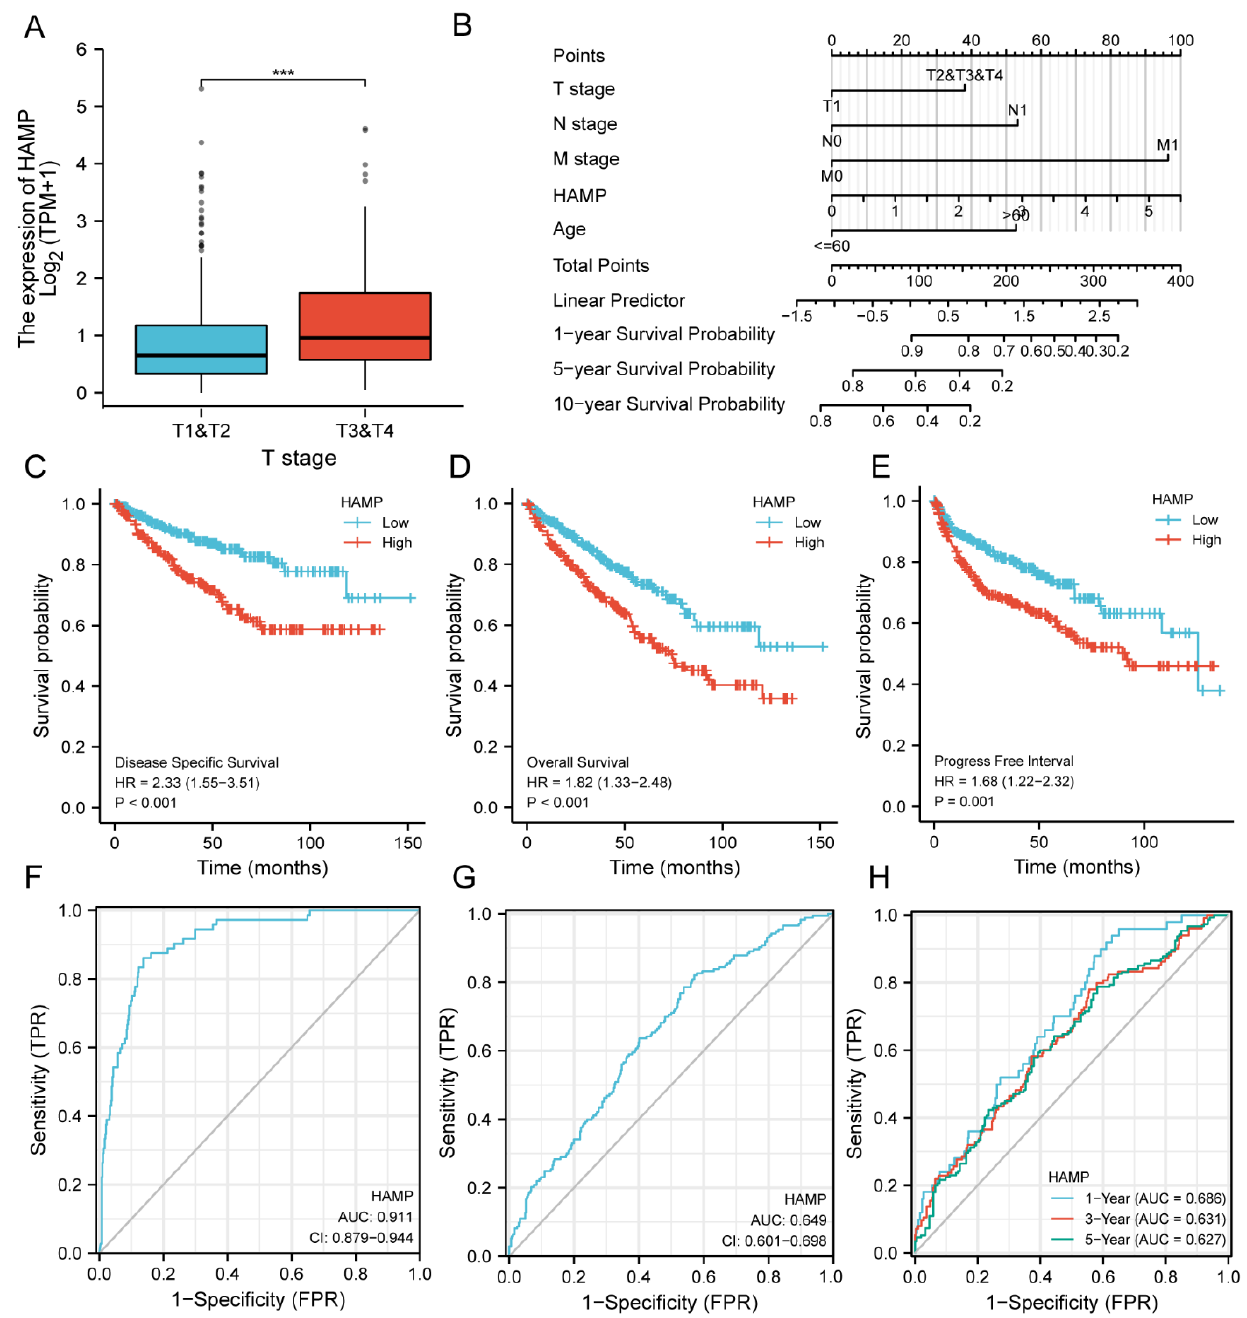
Figure 2. Prognosis and diagnosis based on HAMP expression levels. ( A ) The overexpression of HAMP in Stages T3 − T4 compared with Stages T1 − T2. ( B ) The scores of several factors with HAMP expression levels (T/N/M stage, age, 1/5/10 year survival probability). ( C – E ) Survival curves of OS, DSS and DFD correlated with HAMP expression levels in TCGA kidney cancer cohorts. ( F – H ) The diagnostic ROCs of status, OS and survival time based on HAMP expression levels in KIRC. OS, overall survival; DSS, disease-specific survival; PFI, progression-free interval. (*** p <